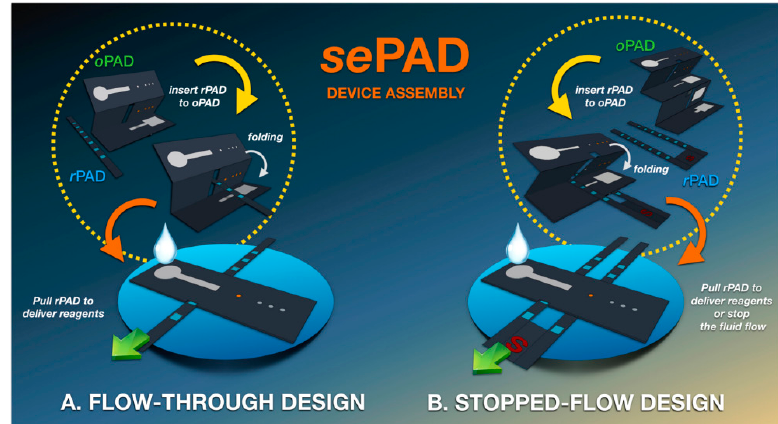
Figure 3. Schematic illustration of the sequential paper analytical device (sePAD) components and device assembly using ( A ) flow-through design and ( B ) stopped-flow design. Reprinted from [26] with permission from American Chemical Society (ACS).